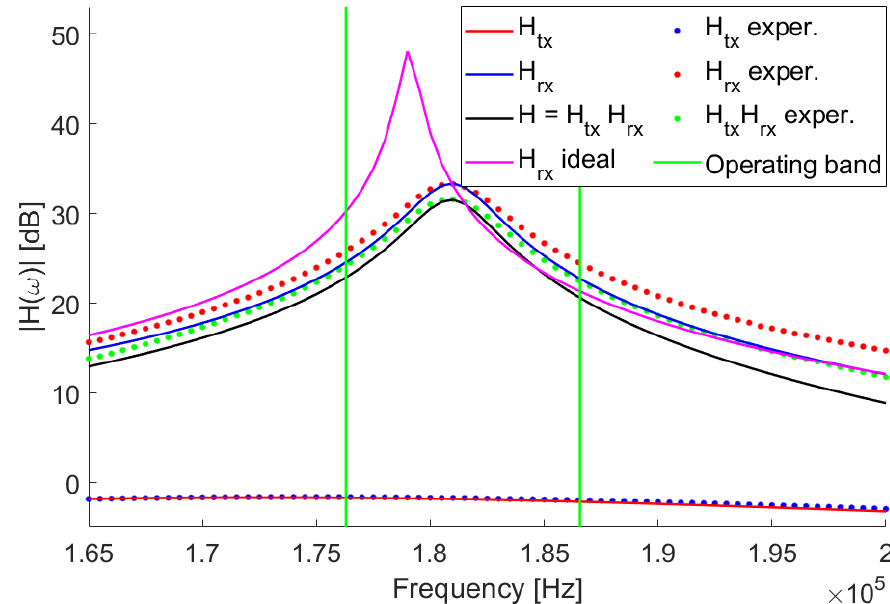
Figure 3. The frequency response, where solid lines are theoretical and dotted lines are experimental: the operating band (see Table 1) is delimited by the vertical green lines.